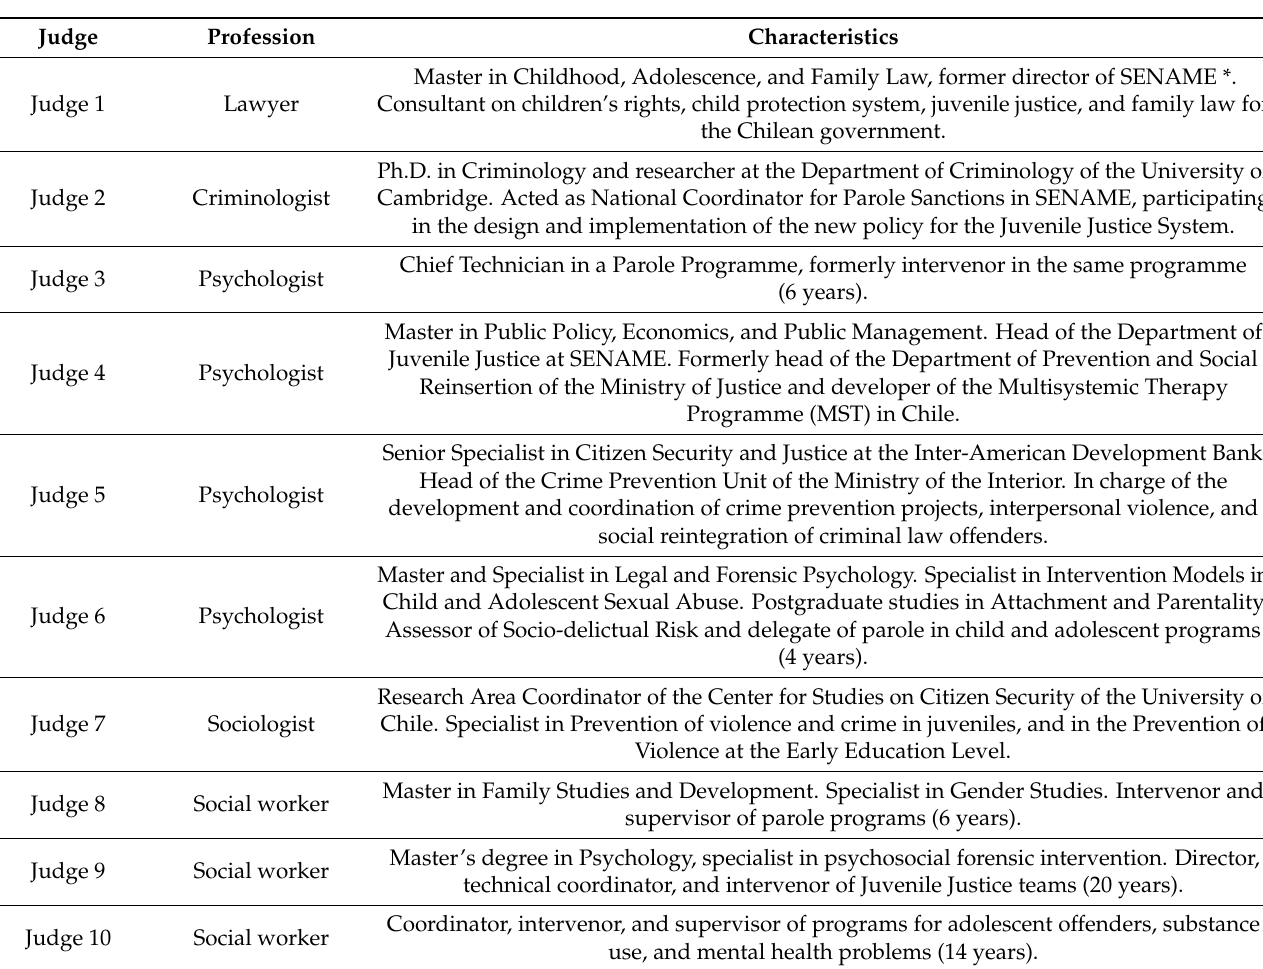
Table 2. Descriptive statistics for the analysis